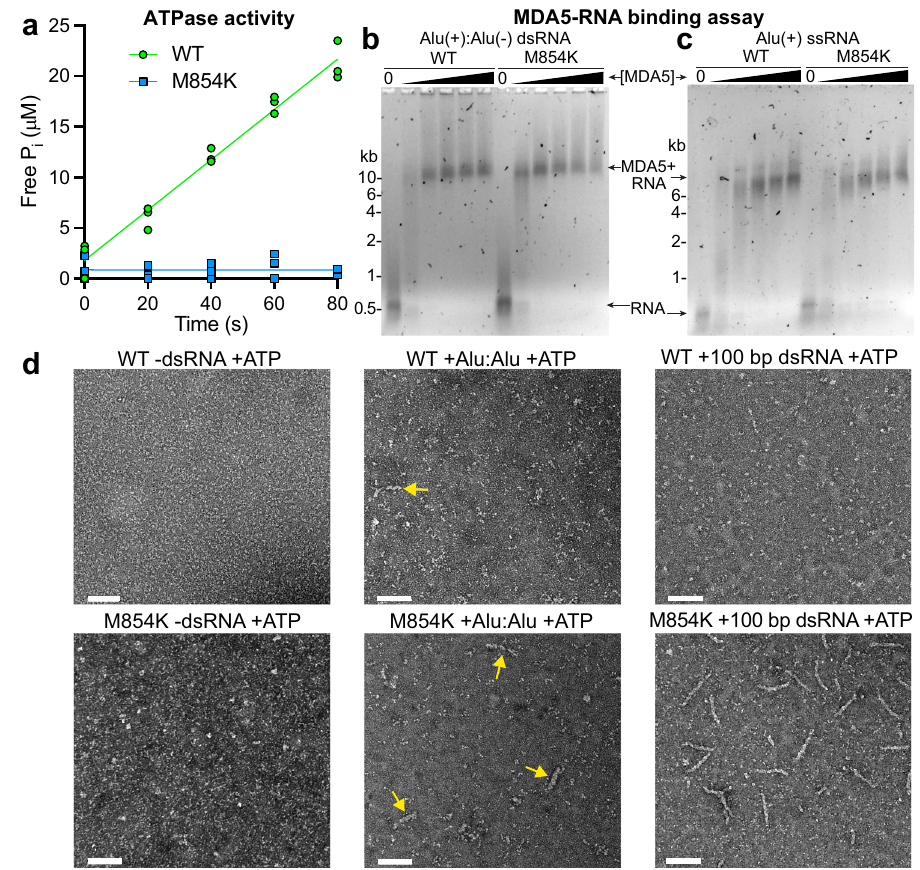
Fig. 2 The ATPase, RNA binding, and fi lament-forming activities of MDA5 M854K. a ATPase assay of WT MDA5 and M854K MDA5 with 1 kb dsRNA. The assay was performed in triplicate with three independently puri fi ed batches of MDA5 protein. b Gel-shift assay (EMSA) of WT or M854K MDA5 (0, 0.2, 0.4, 0.6, 0.8, 1 µ M) mixed with 5 ng/ μ l annealed Alu( + ):Alu( − ) dsRNA, followed by addition of 6 mM ATP. Agarose gels were stained for RNA with SYBR Gold. The M854K variant binds to Alu( + ):Alu( − ) with higher af fi nity than WT MDA5 with ATP present. c EMSA of increasing concentrations of WT or M854K MDA5 after incubation with 5 ng/ μ l Alu( + ) ssRNA performed under the same conditions as in ( b ). The M854K variant binds ssRNA with a similar af fi nity as WT MDA5 with ATP present. d Negative-stain electron micrographs of M854K and WT MDA5 with ATP and Alu( + ):Alu( − ) dsRNA, 100-bp dsRNA, or without dsRNA. Arrows indicate MDA5-Alu:Alu complexes. Scale bar, 100 nm. Micrographs are representative of at least six images collected for each condition (see Supplementary Fig. 2 for additional micrographs). ATPase assays and EMSAs were repeated independently at least three times with similar results. Source data are provided as a Source Data fi